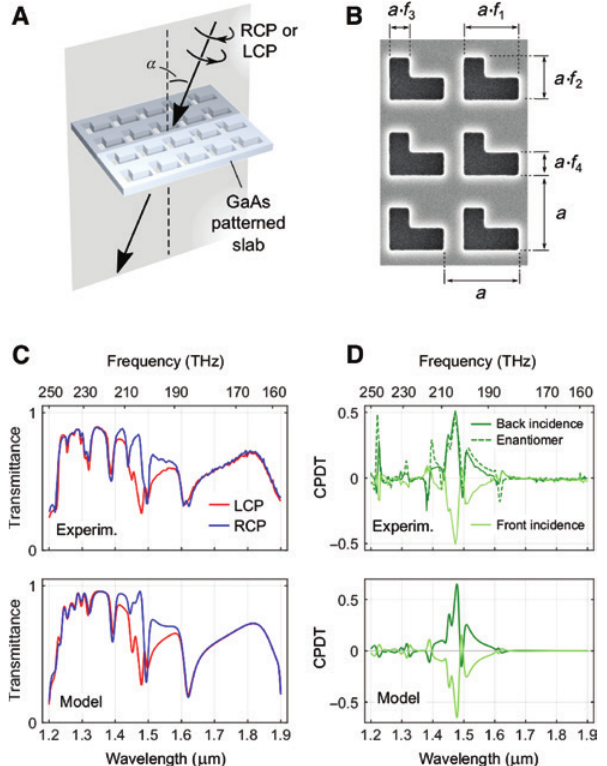
Figure 1: (A) Schematic representation of the metasurface and the optical measurement. RCP and LCP indicates right- and left-circularly polarized light, respectively. (B) Scanning electron micrograph of the metasurface with its geometrical parameters. (C) Polarization-resolved transmittance spectra, both from the experiment and the numerical modeling. (D) Circular polarization differential transmittance CPDT (i.e. difference between LCP and RCP transmittances) measured on the metasurface represented in (B) from both front and back side, and from the front side of a metasurface having the enantiomeric pattern (see text for details). Data in panels (C) and (D) are obtained at α =